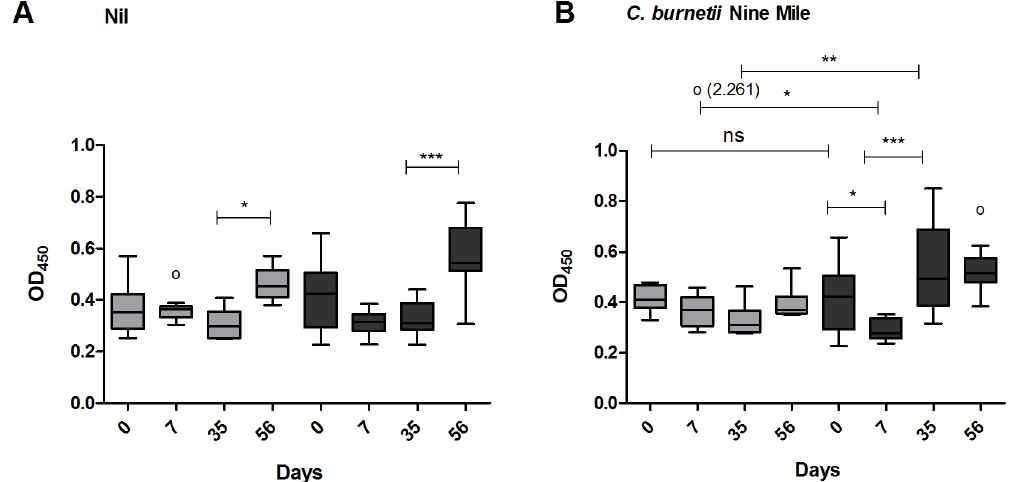
Figure 4. Increased Interferon- c production in C.burnetii infected goats after stimulation with C.burnetii . Stimulation of undiluted heparin blood with nil (4A) or heat killed C. burnetii NM 1 6 10 7 /ml (4B). Grey bars represent six naive goats, dark grey bars represent eleven infected goats. Blood was sampled at day zero and at day 7, 35 and 56 of the study. IFN- c was measured after 24 h incubation using the Bovigam IFN- c ELISA kit. Box and Whisker plots are shown. Outliers are indicated as open circles. NS; not significant *p , 0.05; **p , 0.01; ***p , 0.001, Mann-Whitney U-test.